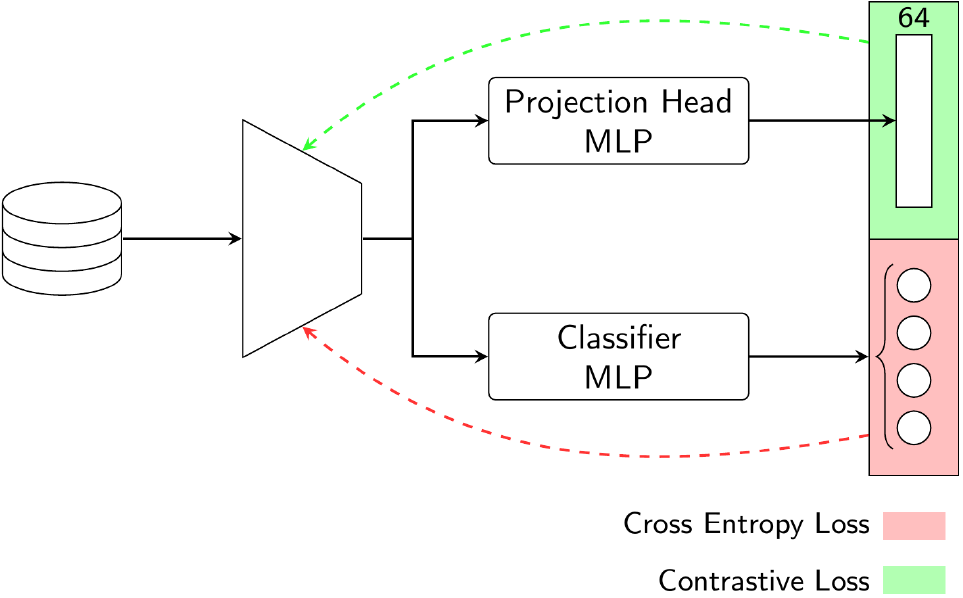
Figure 8. Model’s architecture in simultaneous multi-loss training. The losses used are the contrastive loss and the cross-entropy